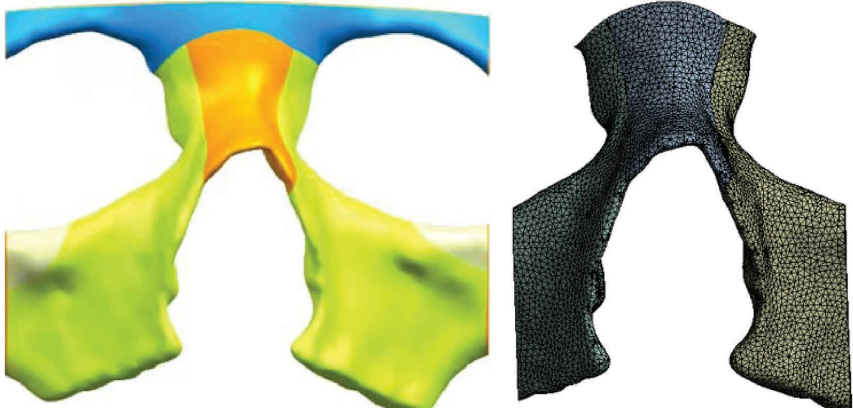
Figure 1: Nasomaxillary complex model and mesh model.